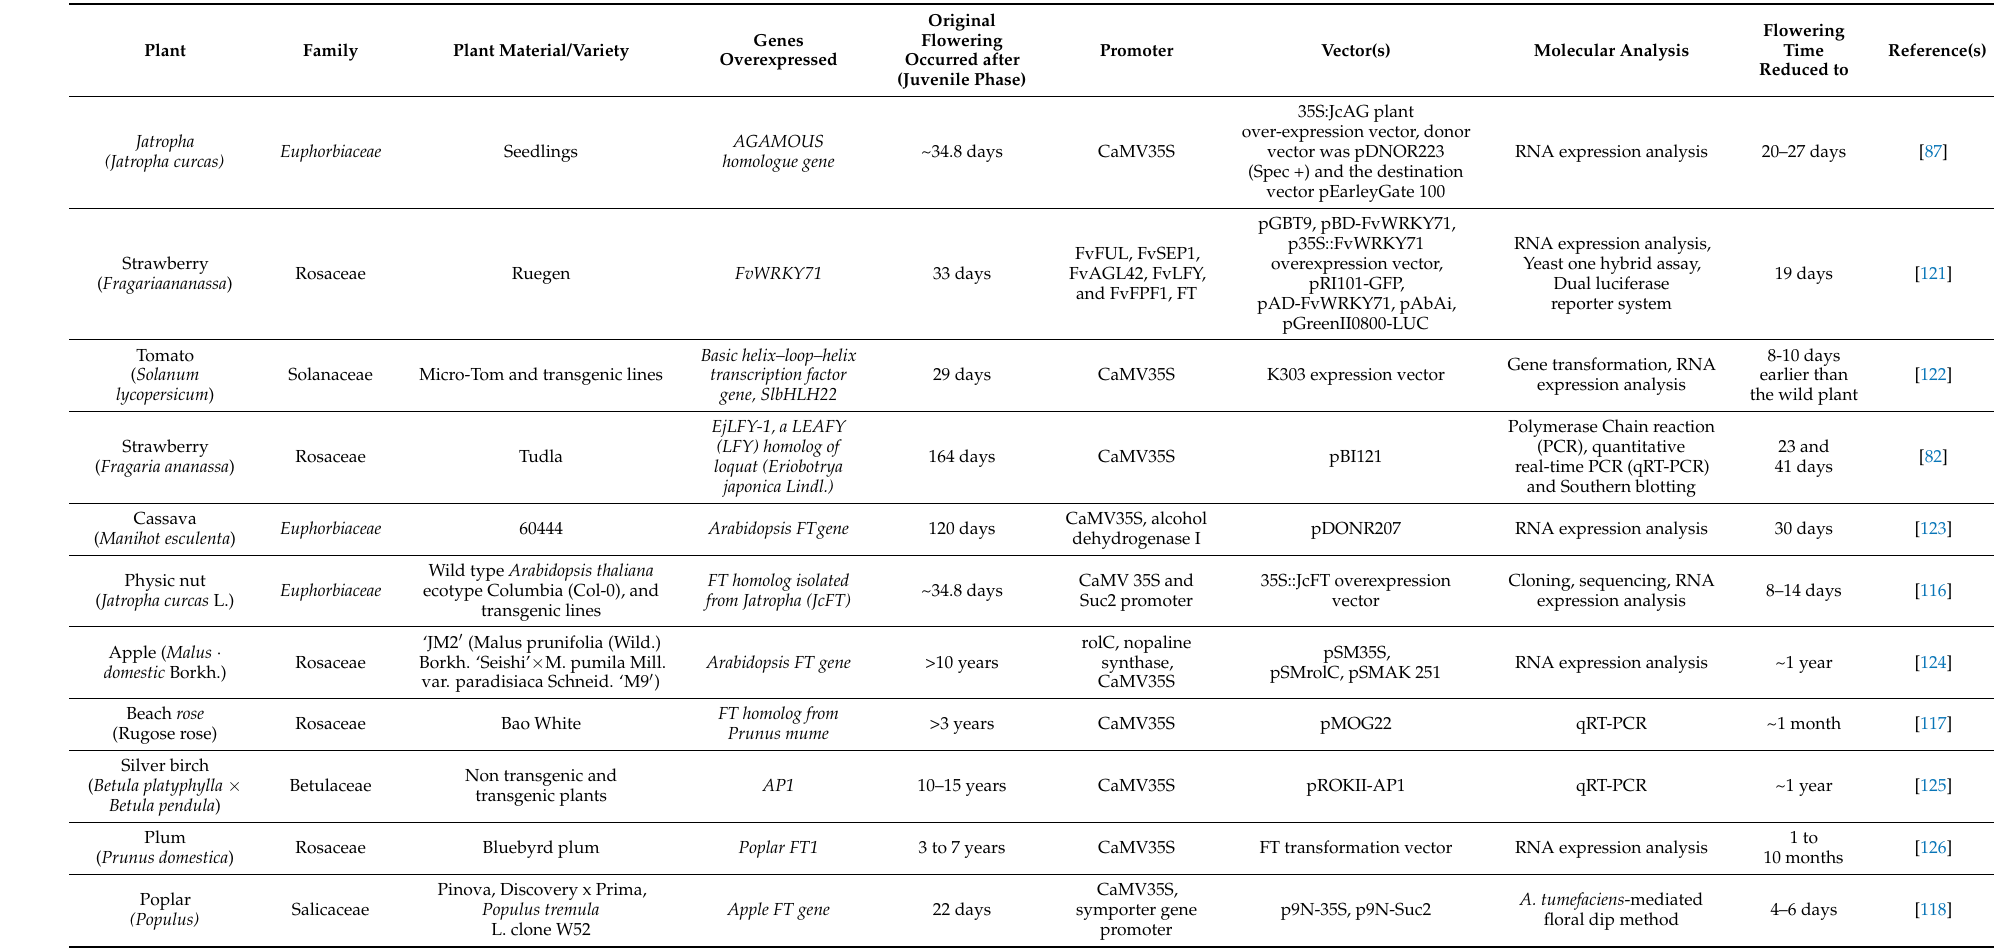
Table 1. Overexpression studies for the induction of early flowering in